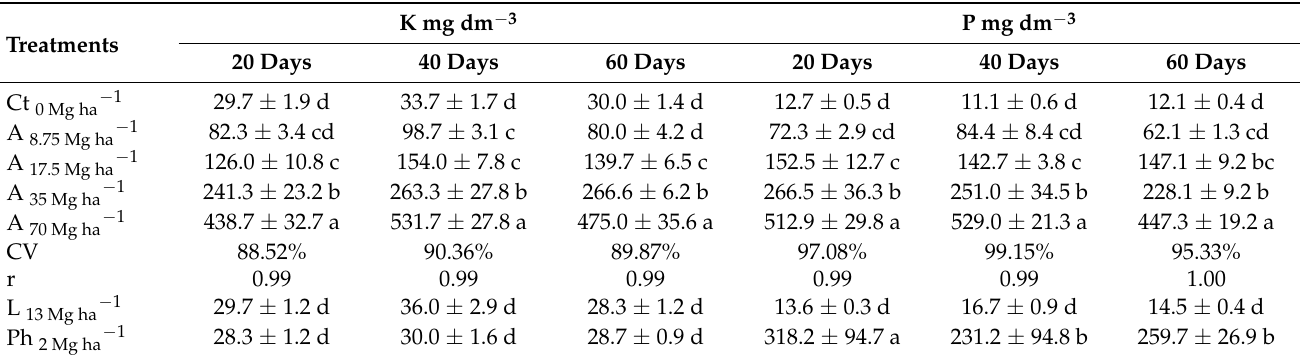
Table 4. Chemical attributes of Yellow Latosol as a function of the application of ash from Amazonian biomasses, lime, and phosphate fertilizer. Mean values and standard deviations of extractable K and P nutrients after the three incubation